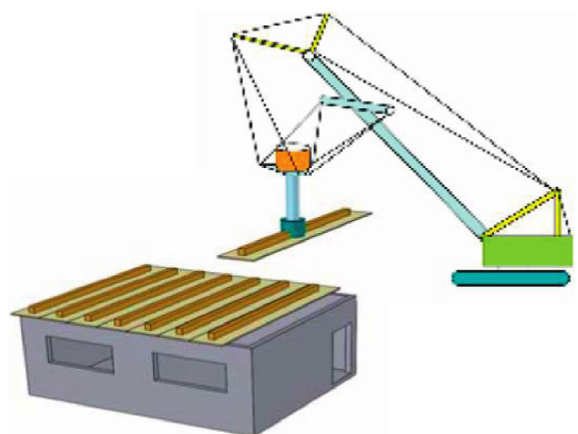
Figure 7: Horizontal floor construction [14].